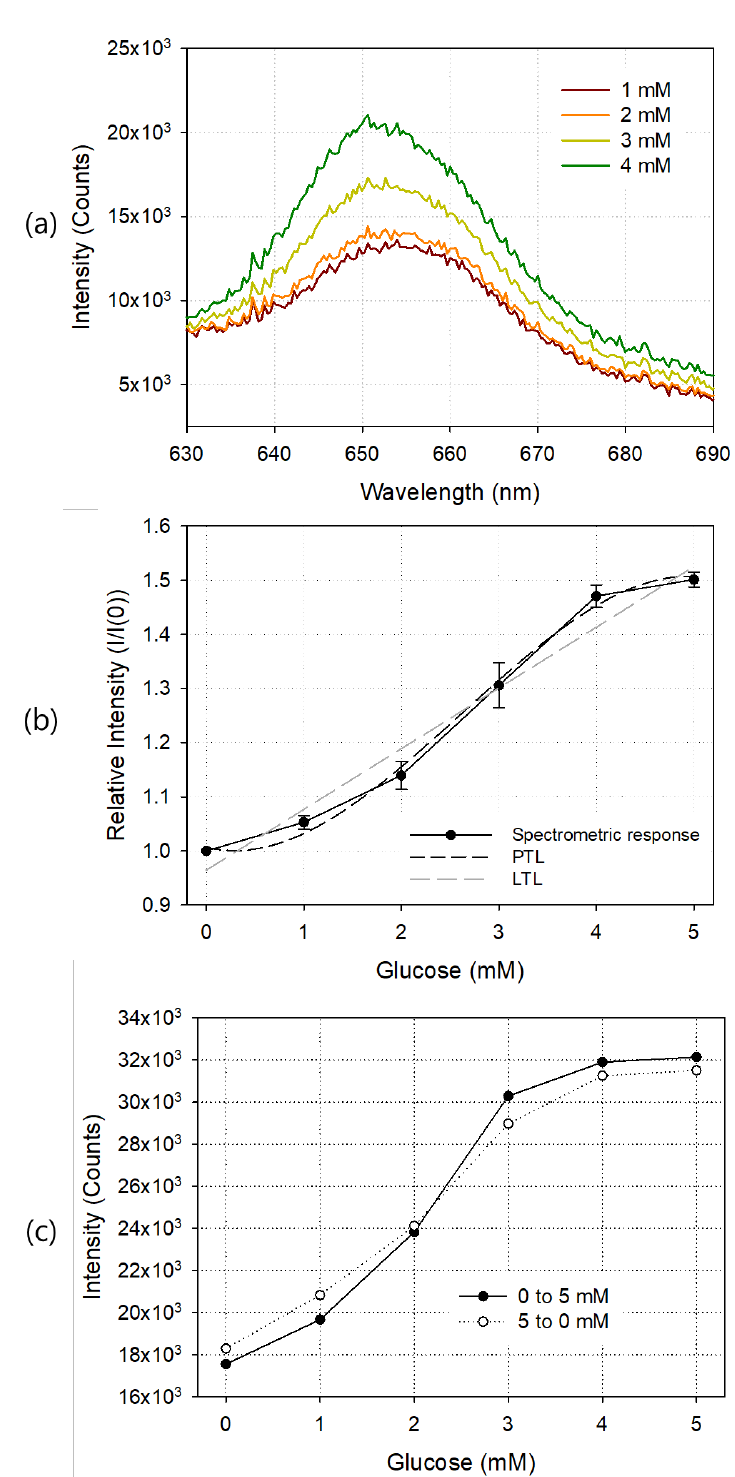
Figure 5. Exemplary output waveforms at 1, 2, 3, and 4 mM glucose ( a ), spectrometric responses ( b ), and hysteresis curve ( c ) of the manufactured glucose sensor. In ( b ), linear trendline (LTL) and third degree polynomial trendline (PTL) for the response curve are also shown. Each result is an average of five measurements, and the error bar represents the standard deviation.